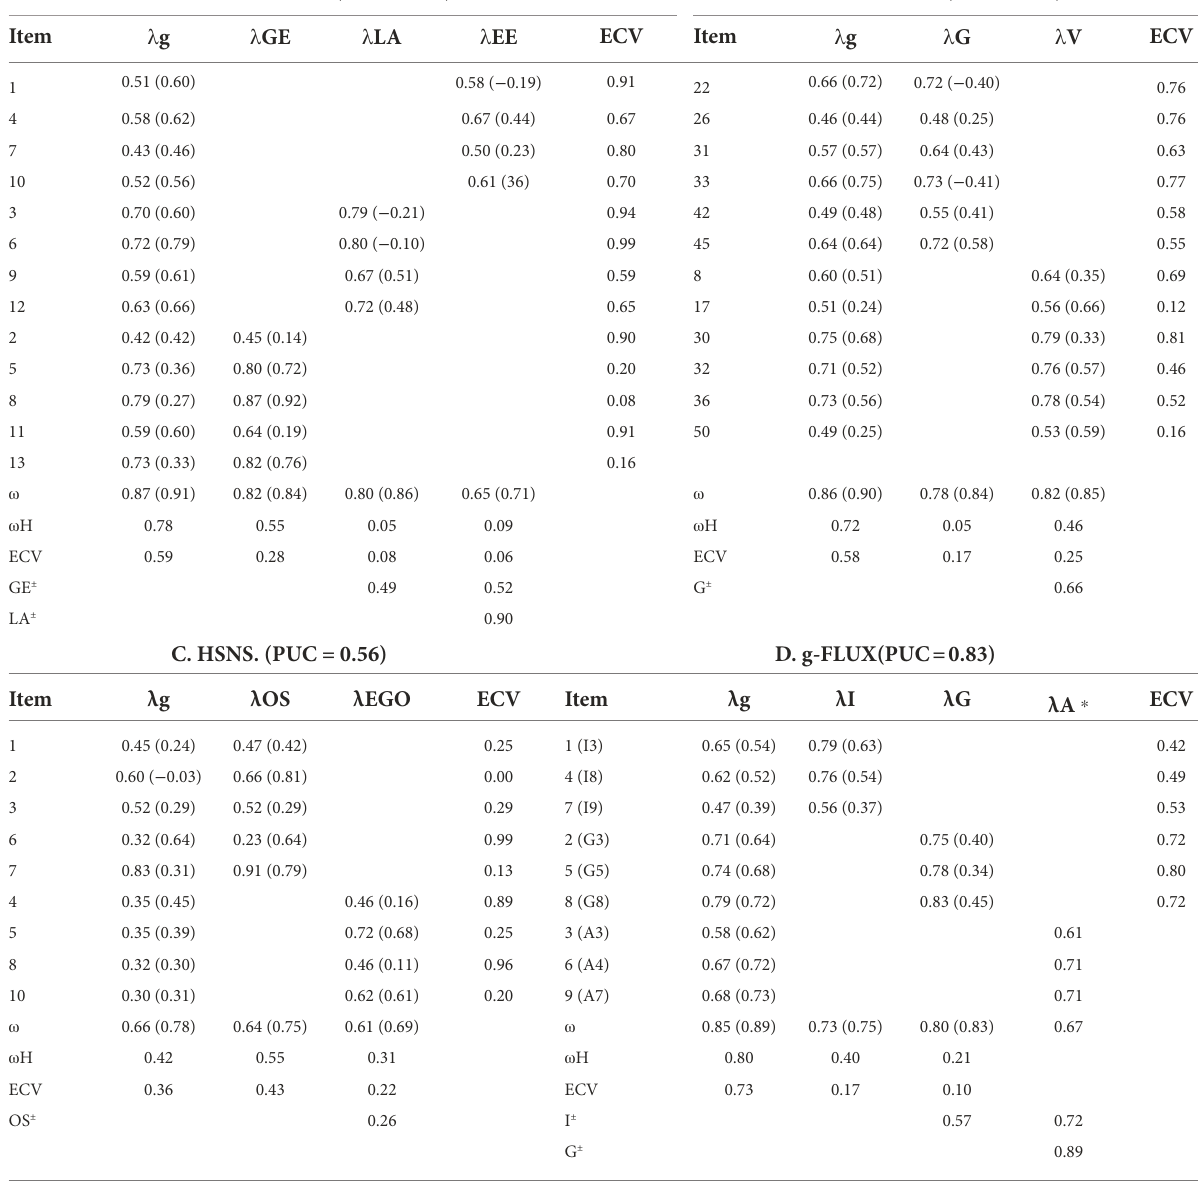
TABLE 2 Factor loadings and bifactor indices of narcissism scales and subscales. A. NPI-13 (PUC = 0.72) B. SB-PNI (PUC =